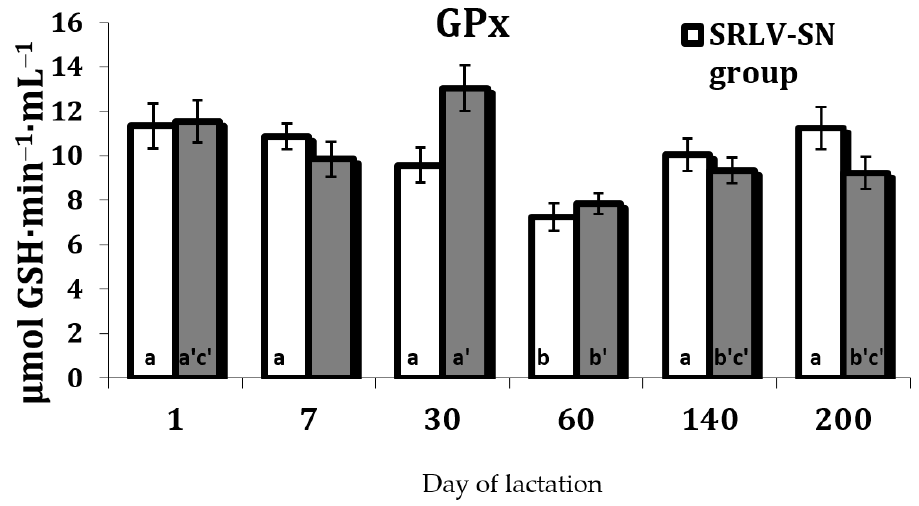
Figure 9. Glutathione peroxidase activity ( µ mol GSH · min − 1 · mL − 1 ) in the serum of SRLV-SN and SRLV-SP goats during lactation. Values are expressed as means ± SEM; a, b, c—different letters indicate significant differences between stages of lactation within the SRLV-SN group at p < 0.05; a’, b’, c’—different letters indicate significant differences between stages of lactation within the SRLV-SP group at p < 0.05; SRLV-SP—small ruminant lentivirus seropositive goats; SRLV-SN—small ruminant lentivirus seronegative goats.